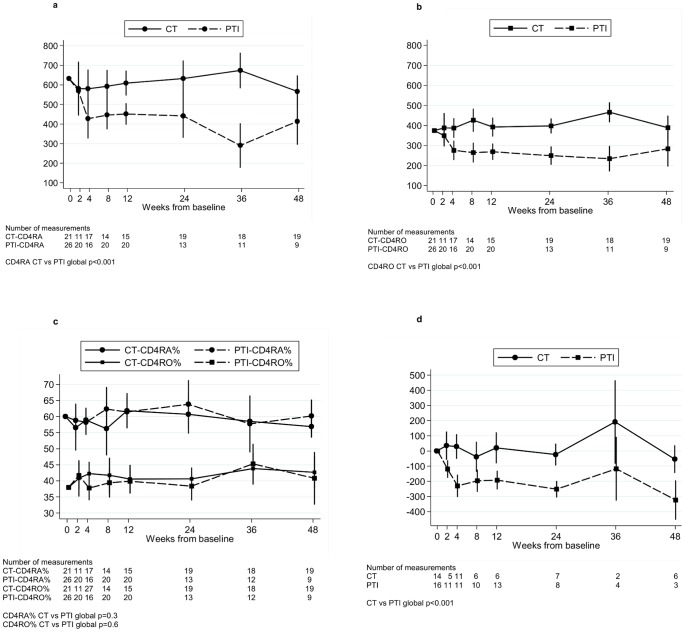
Changes in CD45RA, CD45RO and CD45A+CD31+ cells.Changes in absolute numbers of CD45RA cells (a), CD45RO cells (b) and CD4 RA and RO cells as a % of CD4 cells, for children in the trial where of CD4 sub-populations were evaluated (including the children in the substudy) (c). Change in CD45RA+ CD31+ cells from baseline for children in the substudy (d). CT  =  continuous ART (antiretroviral therapy), PTI  =  planned treatment interruption (off ART). Changes from baseline were estimated using normal regression of actual measurements adjusting for baseline using the overall mean at randomisation as the reference category.